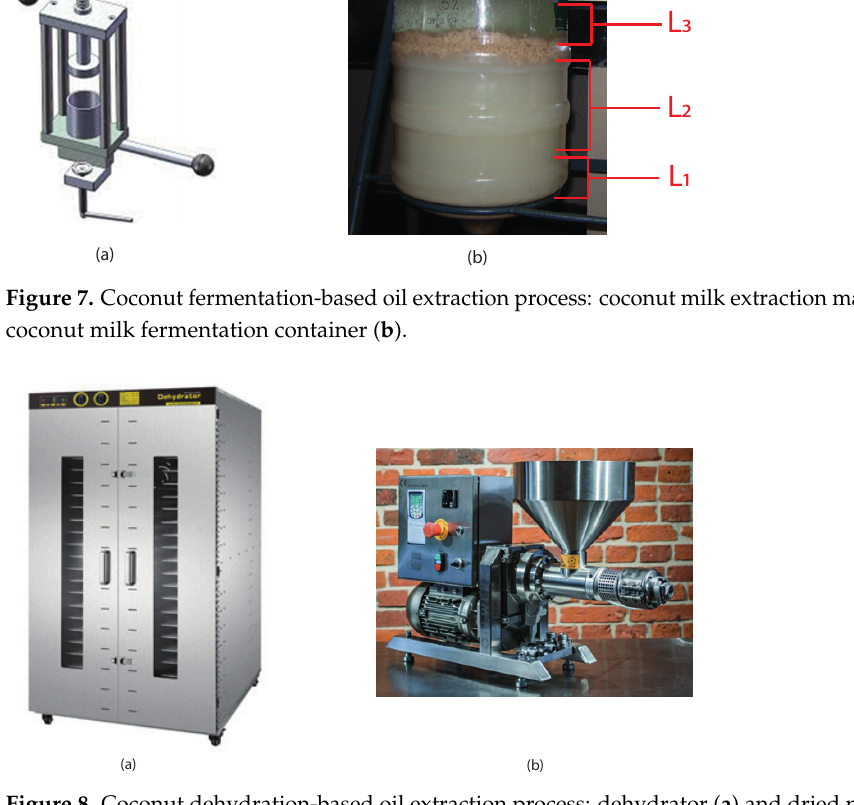
Figure 8. Coconut dehydration-based oil extraction process: dehydrator ( a ) and dried pulp press ( b